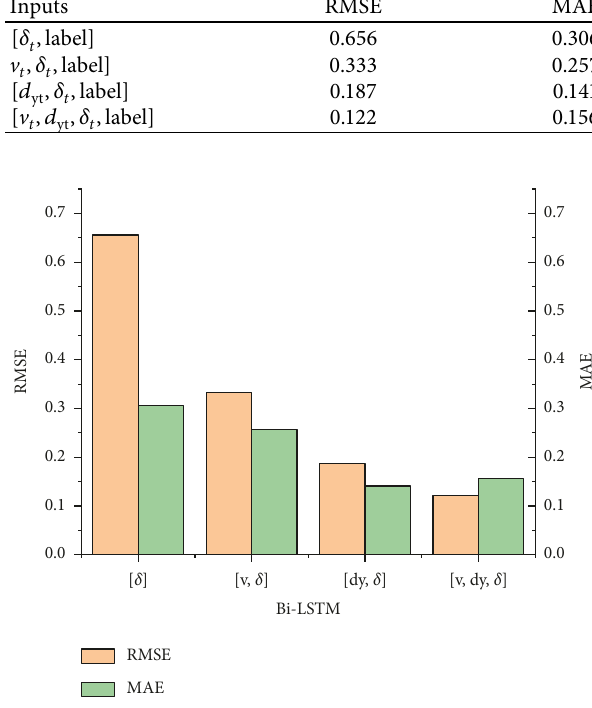
Figure 15: Effect of inputs on Bi-LSTM model